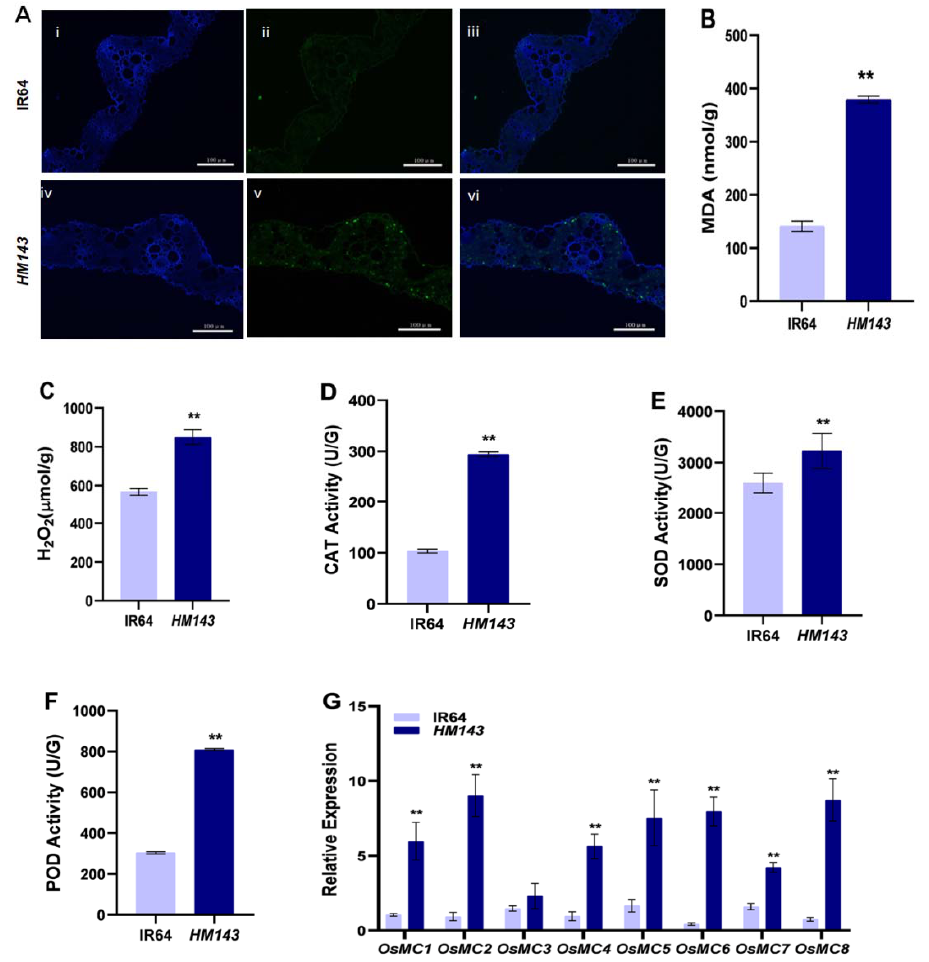
Figure 1. Analysis of cell death and ROS accumulation in IR64 and HM143 at tillering stage. ( A ) TUNEL assay. Blue signal represents 4 (cid:48) , 6-diamino-phenylindole (DAPI) staining; green color represents positive result. (i) and (iv) are DAPI staining; (ii) and (v) are TUNEL signal; (iii) and (vi) are merged images of (i/iv) andrespectively, Bar = 100 µ m; ( B ) Malonaldehyde (MDA) contents; ( C ) H 2 O 2 contents; ( D – F ) CAT, SOD and POD enzyme activities ( G ) Expression analysis of OsMCs genes. Data are means ± SD of three biological replicates (Student’s t -test: * ** p <